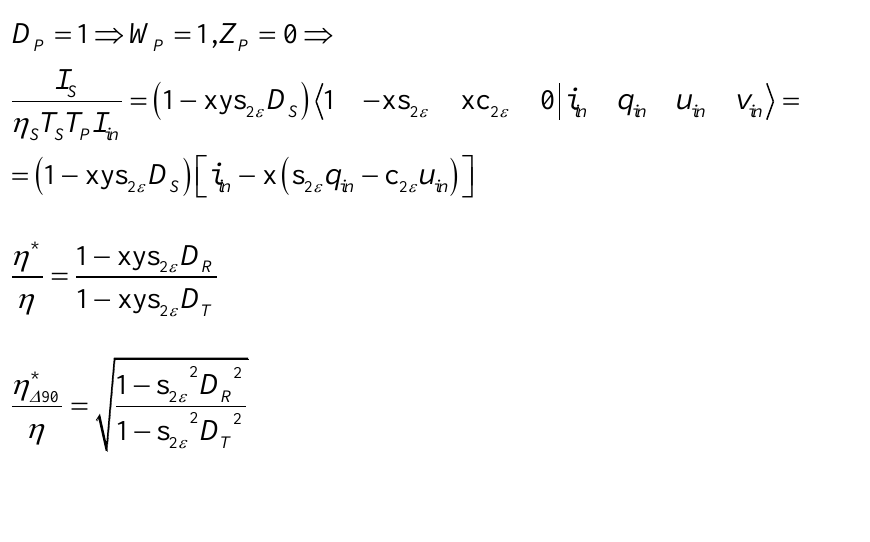
With an ideal linear polariser Eq. (123) becomes Eq. (127), and the gain ratios in Eq. (128) are independent of I independent of the laser polarisation, of the atmospheric depolarisation, and of any optics before the calibrator. The error due to the calibrator rotation ε is largely reduced with the Δ90 calibration in Eq. (129) compared to the ±45° calibration in Eq.